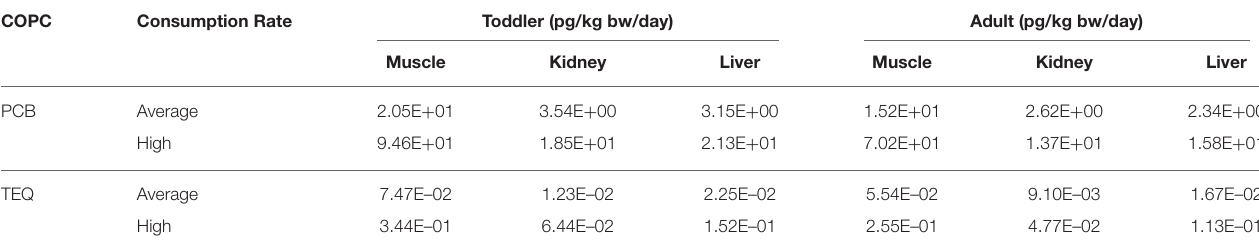
TABLE 5 | CDI values for PCB and TEQ levels in moose tissue. COPC